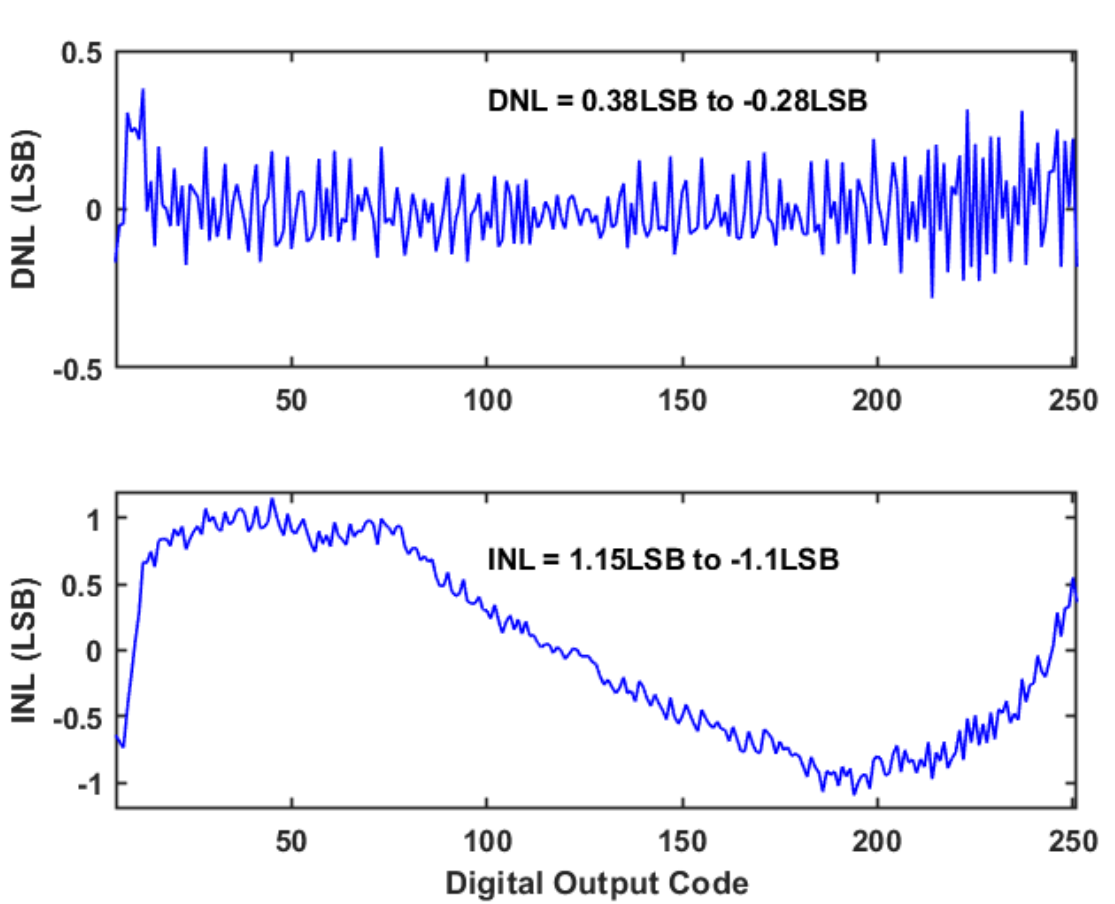
Figure 12. Measured INL and DNL.